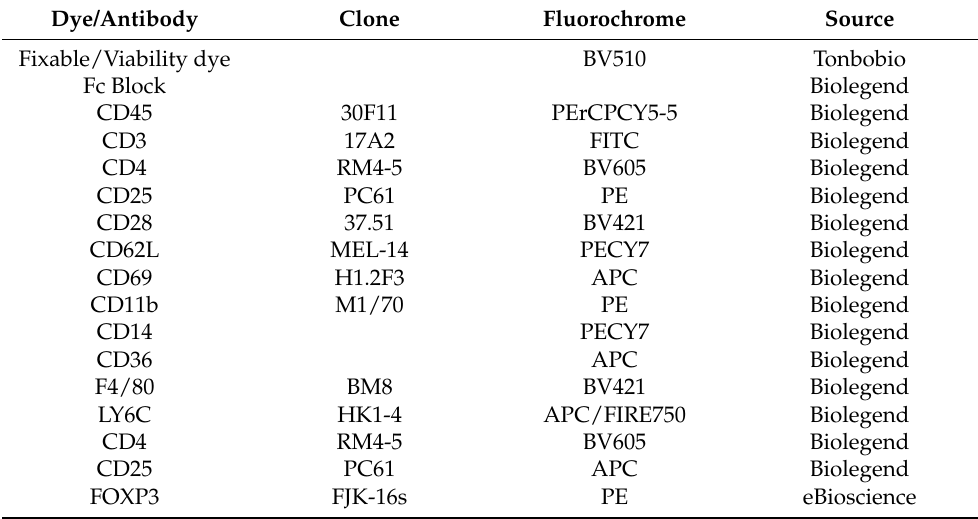
Table 1. Reagents used for flow